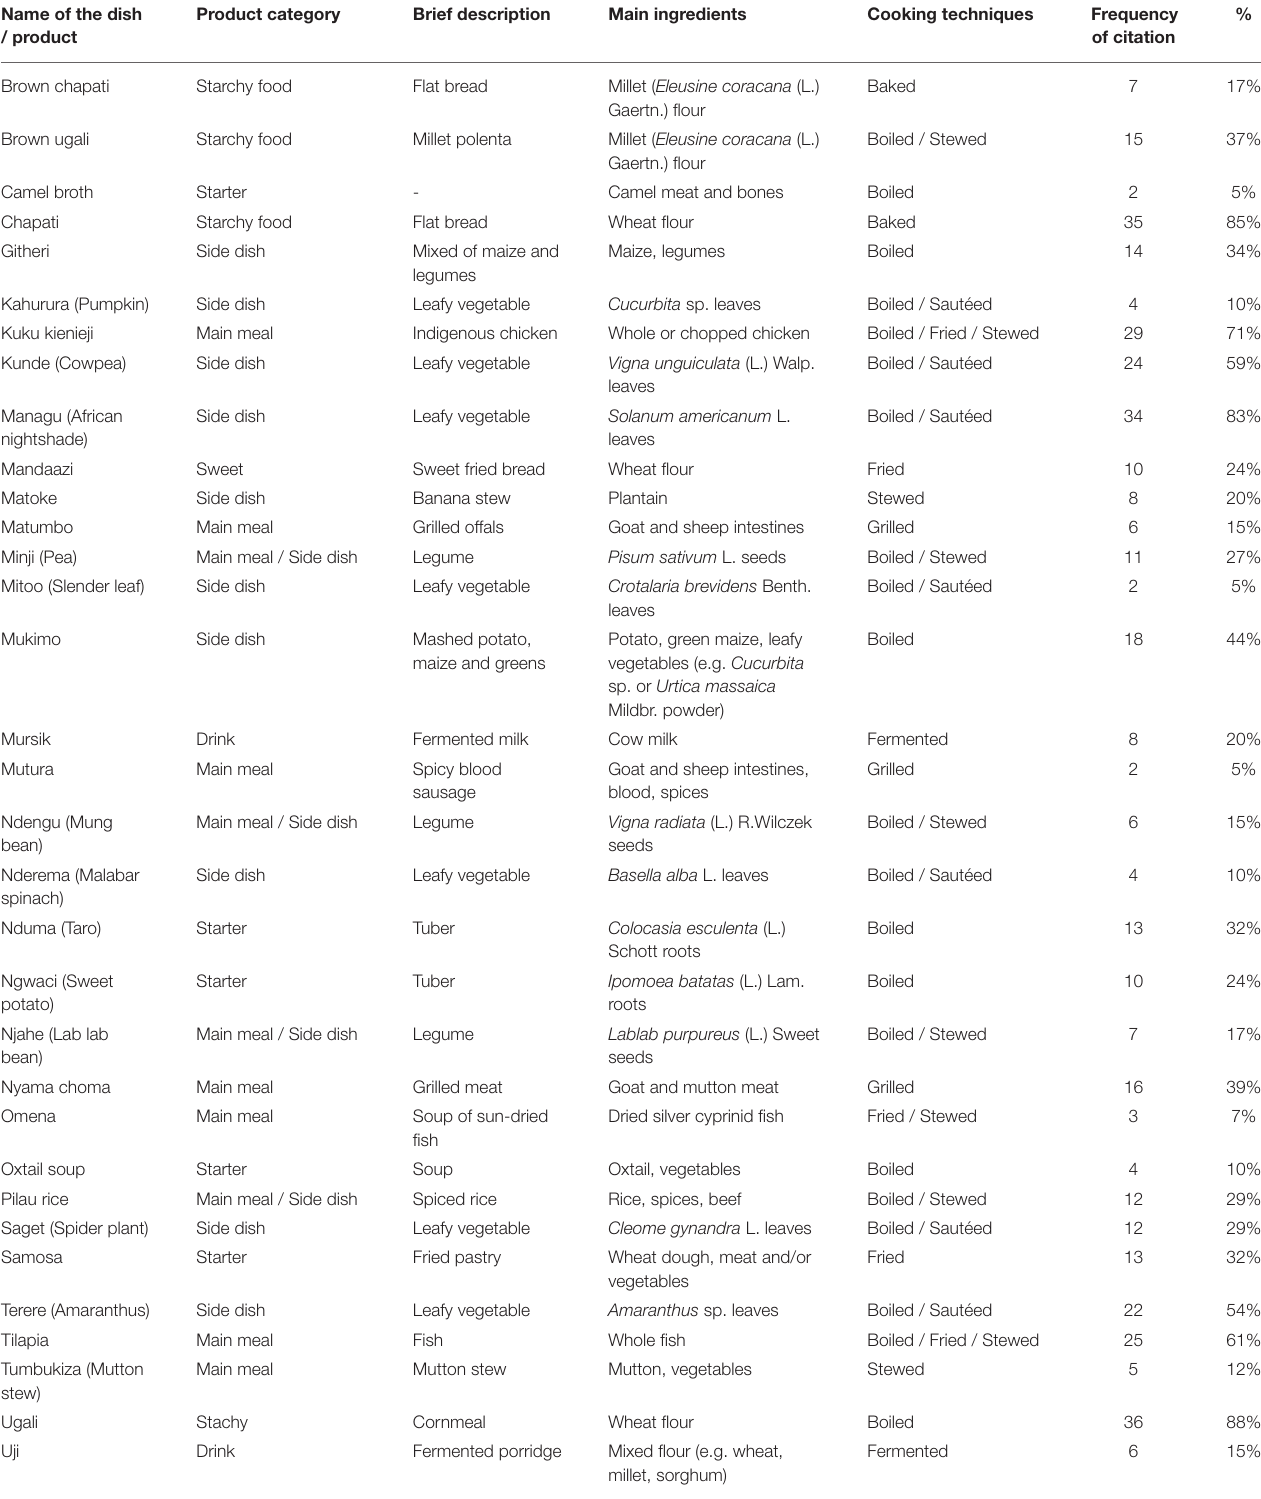
TABLE 3 | List of the most representative Kenyan traditional dishes and ingredients documented during the fieldwork. Name of the dish /